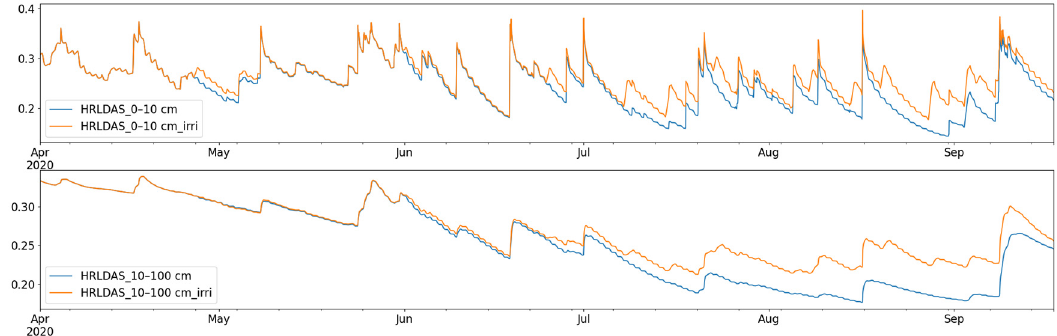
Figure 10. HRLDAS SM with and without in situ irrigation information incorporated in 2020, averaged over three sites inside Nebraska (from top to bottom: 0–10 cm, 10–100 cm depth).